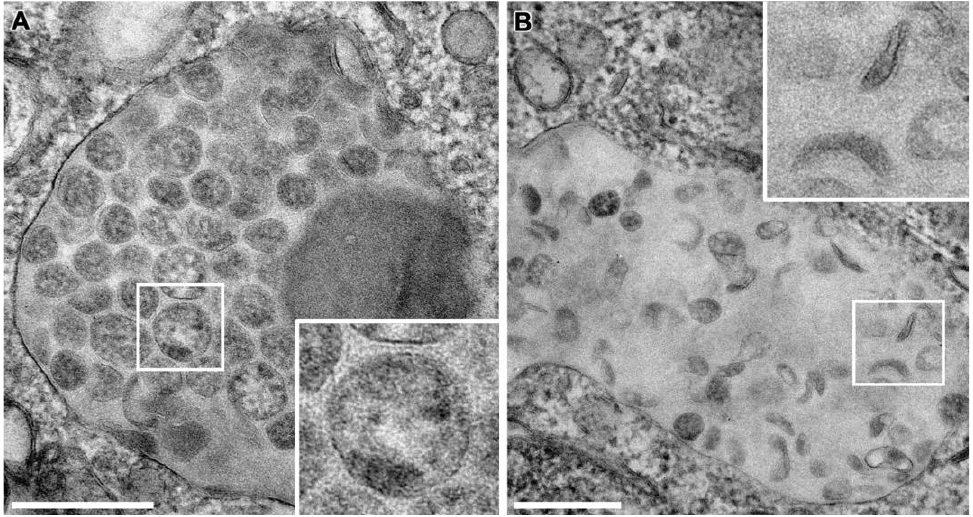
Figure 7. TEM images of large intracellular compartments containing SARS-CoV-2 virions lacking S protein in Vero E6 cells at 24 hpi. Virions within these compartments were ( A ) circular/oval or ( B ) spindle and sickle-shaped. None of the virions exhibited S protein on their surface. Scale bars, 250 nm.